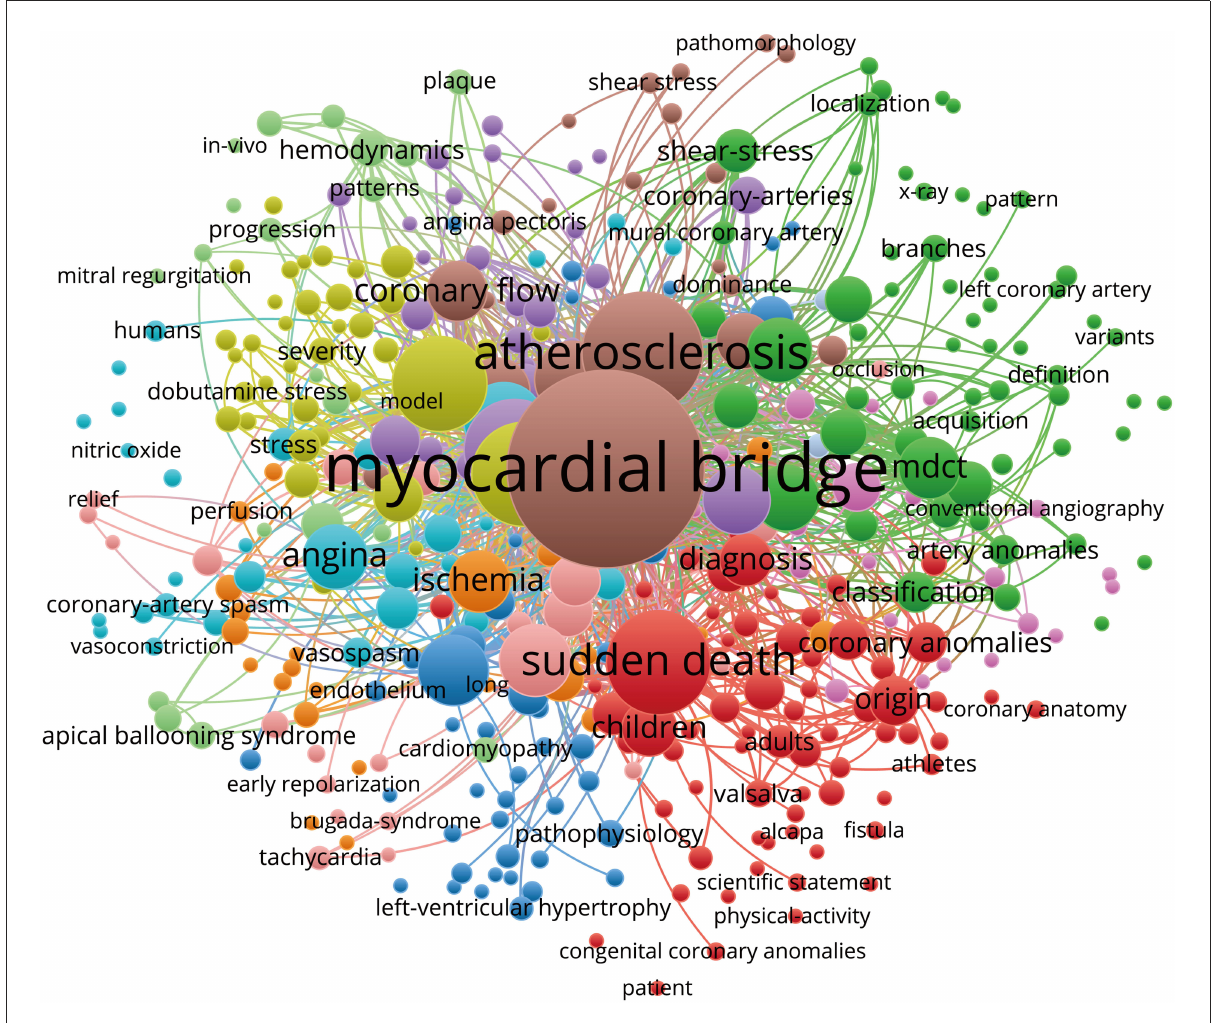
FIGURE4 Keywords co-occurrence map of publications on the myocardial